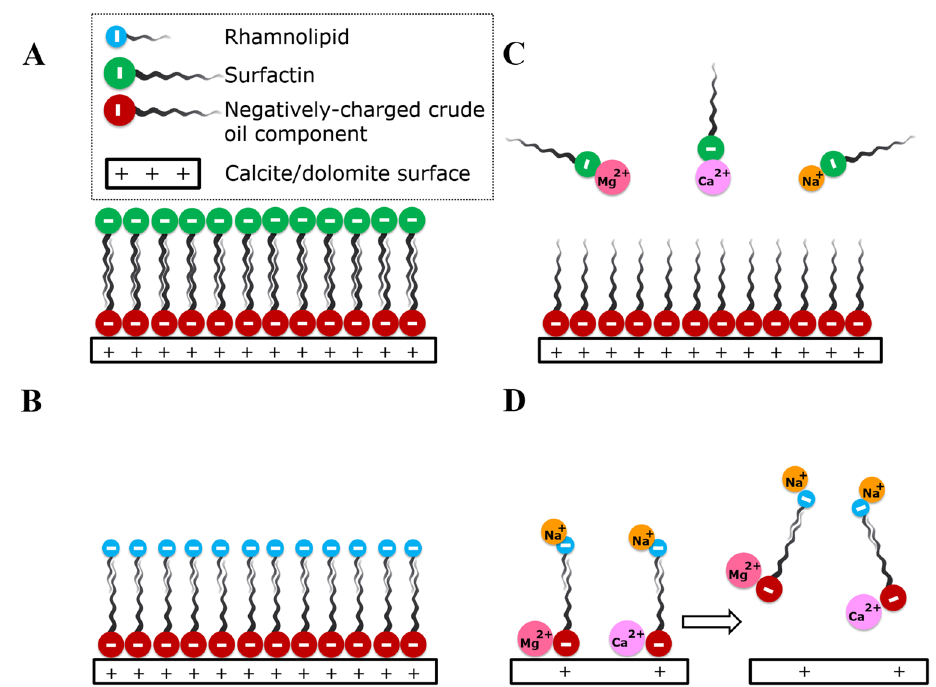
Fig. 3 Surfactin and rhamnolipid can change the wettability of car- bonate surfaces depending on salinity. In zero salinity, a surfactin and b rhamnolipid change the wettability to water-wet and neutral-wet states, respectively. This difference seems to be due to different HLBs of these surfactants. In the salinity of the seawater, c electrostatic interaction between the polar head of surfactin and cations presents in the seawater inhibits wettability alteration. d In the case of rham-